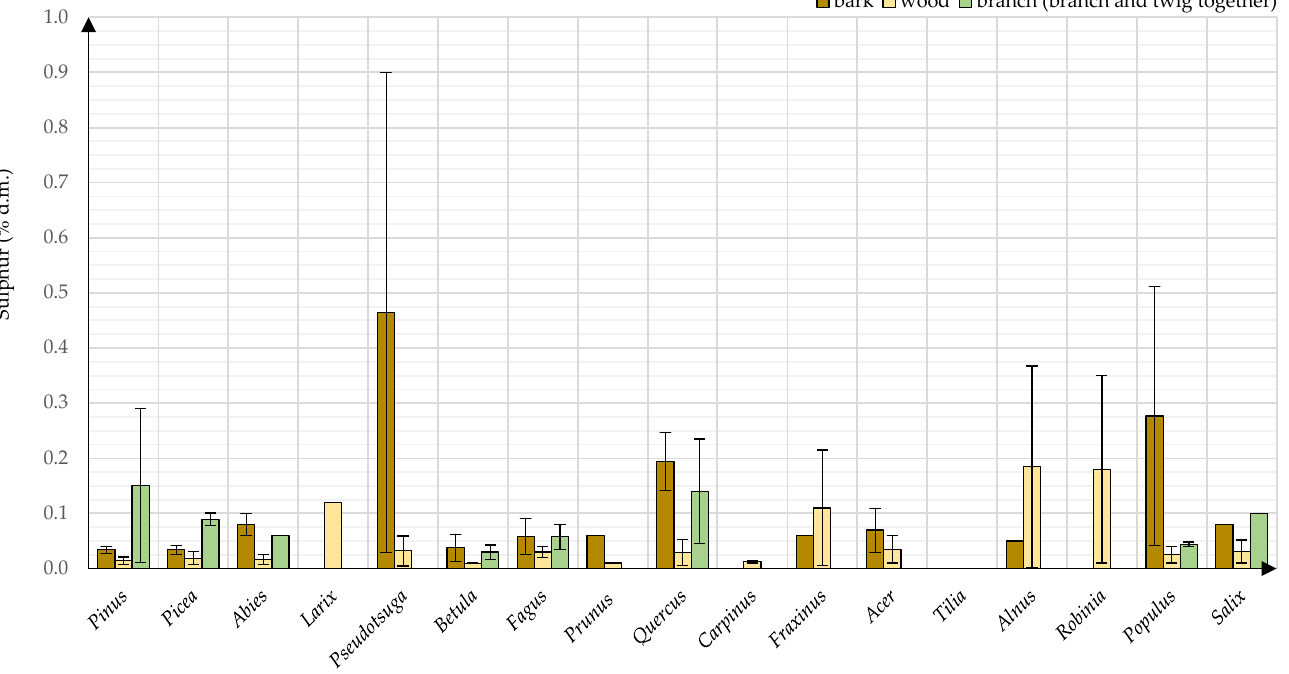
Figure 12. Average value and average deviation of the sulphur content of organs of particular systematic genera trees.